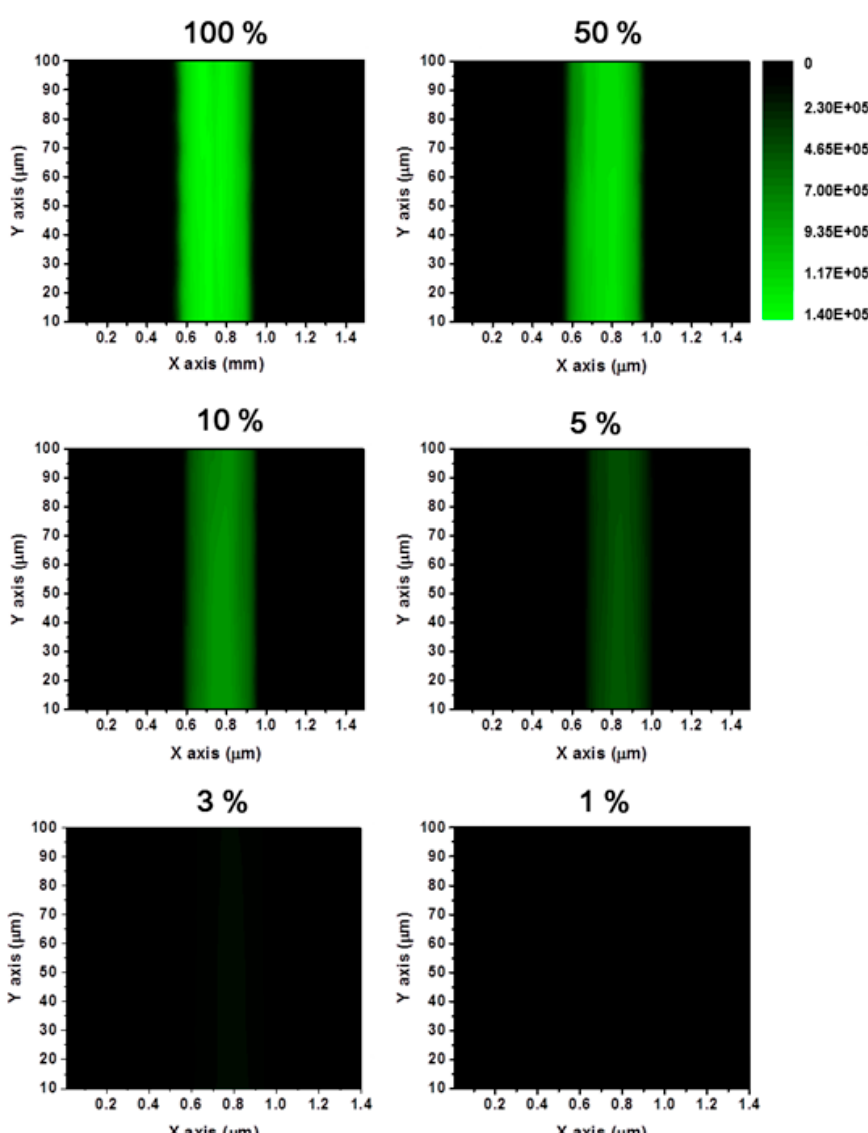
Figure 8. Fluorescence images of the silicon tubes filled with different concentrations of the fluorescent solution ranging from 1 to 100%.